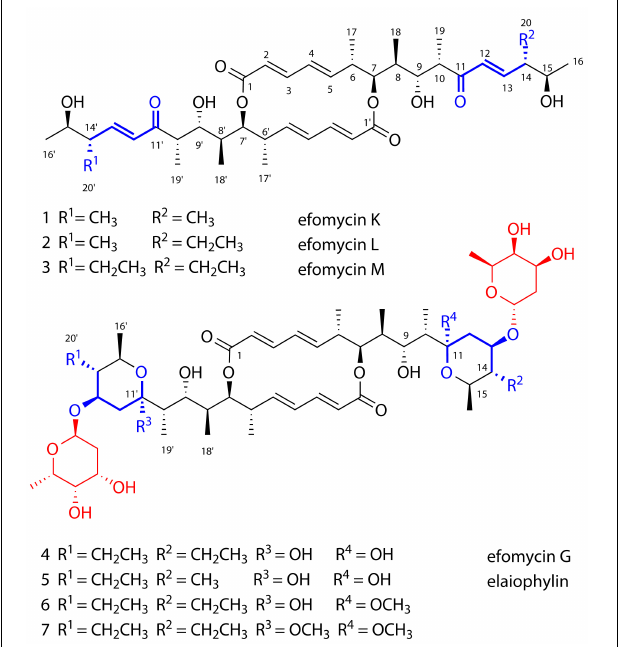
FIGURE 1 | Structures of isolated efomycin and elaiophylin derivatives ( 1 – 7